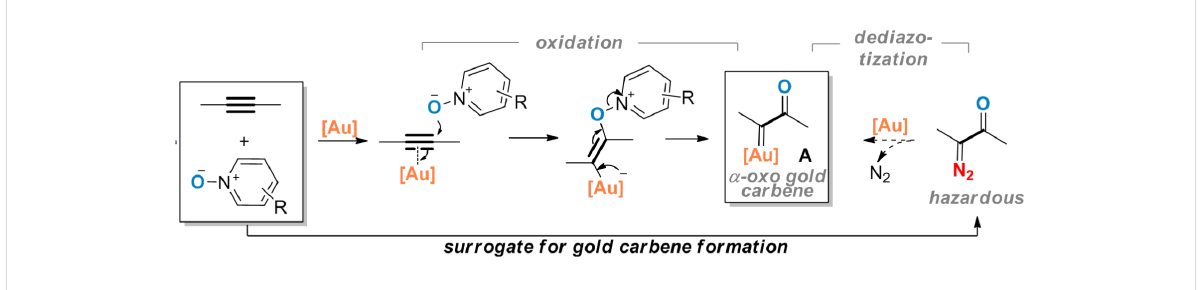
Scheme 1: Generation of α -oxo gold carbenes via intermolecular oxidation of alkynes: a non-diazo approach.